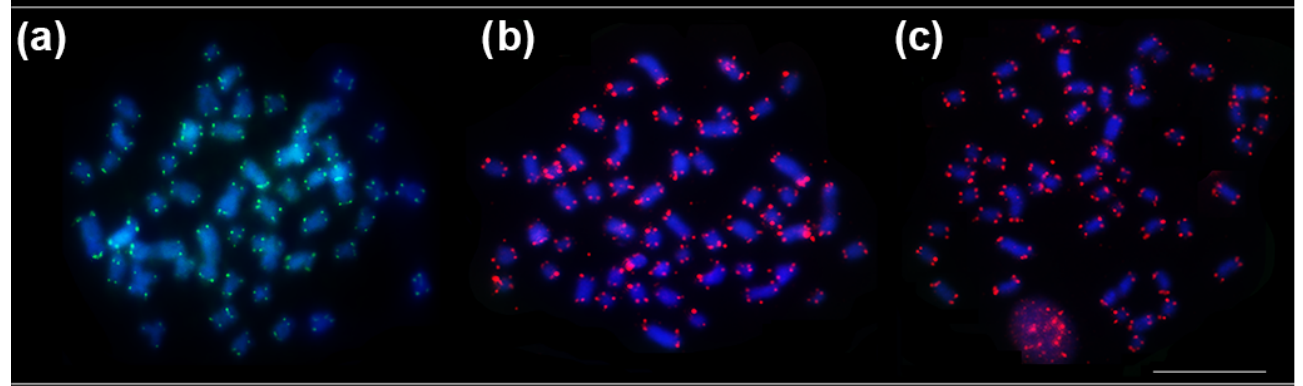
Figure 3. Fluorescence in situ hybridization indicating the physical location of telomeric sequences in the karyotypes of P seudacanthicus species . In ( a ) P. spinosus , in ( b ) P. leopardus , and in ( c ) Pseudacanthicus sp. Hybridization signals were detected with FITC (green) and Cy3 (red), chromosomes were counterstained with DAPI (blue).